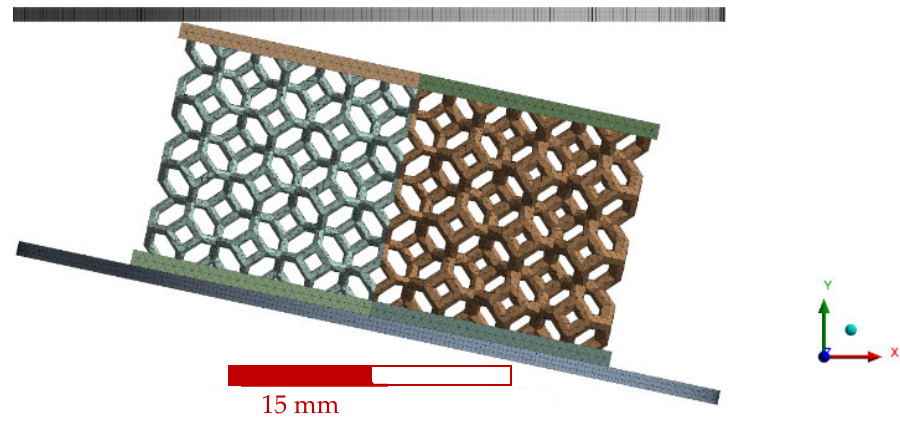
Figure 4 . Side ‐ graded lattice full mesh with bottom plate and impactor. Figure 4. Side-graded lattice full mesh with bottom plate and